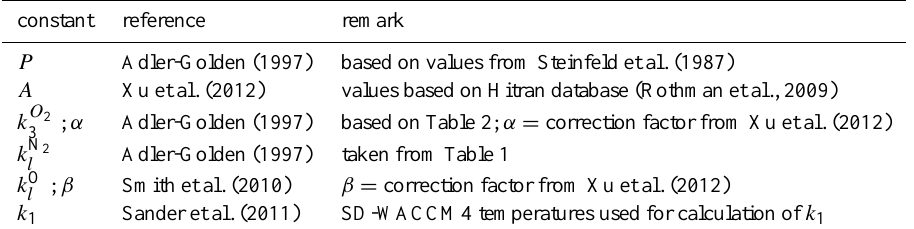
Table 1. Employed constants to Eq. (2). constant reference remark Adler-Golden (1997) based on values from Steinfeld et al. (1987) values based on Hitran database (Rothman et al., 2009) based on Table 2; α = correction factor from Xu et al. (2012) taken from Table